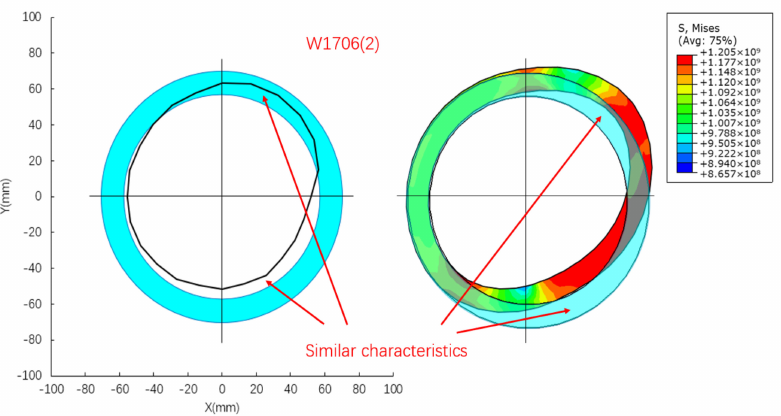
Figure 14. Eccentric deformation section of w1706(2) (black curve) and model 6060 (colored circle) against the initial casing section (blue